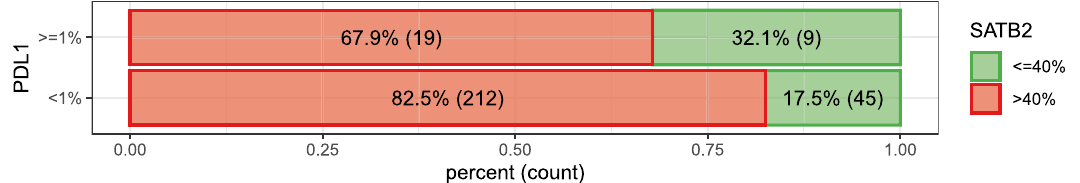
Figure 5. Bar chart documenting borderline insignificant enrichment of SATB2 negative CRCs with PD-L1 expression in ≥ 1% tumor cells (logistic regression, p = 0.066).